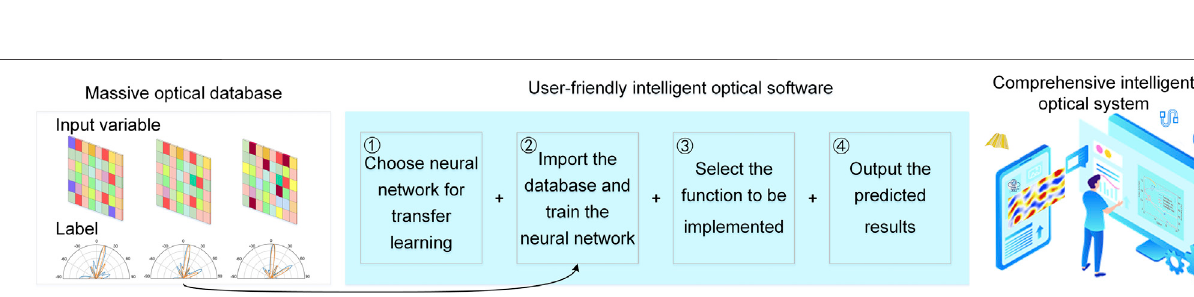
Figure 5 . The platforms to achieving ONNs mainly include photonic circuits and optical diffractive layers as discussed following.